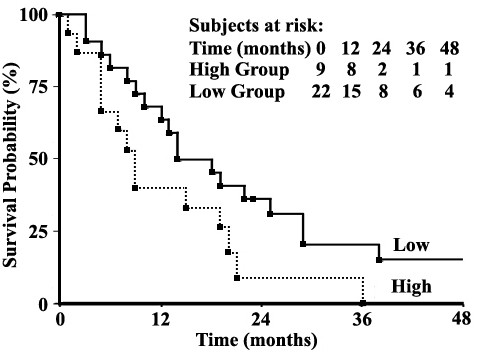
Correlation of 14-3-3σ expression in pancreatic cancer tissues with patient survival. Using Kaplan-Meier analysis, the high 14-3-3σ expression group has a trend of lower survival rate than the low expression group (p = 0.06, Log-Rank test).